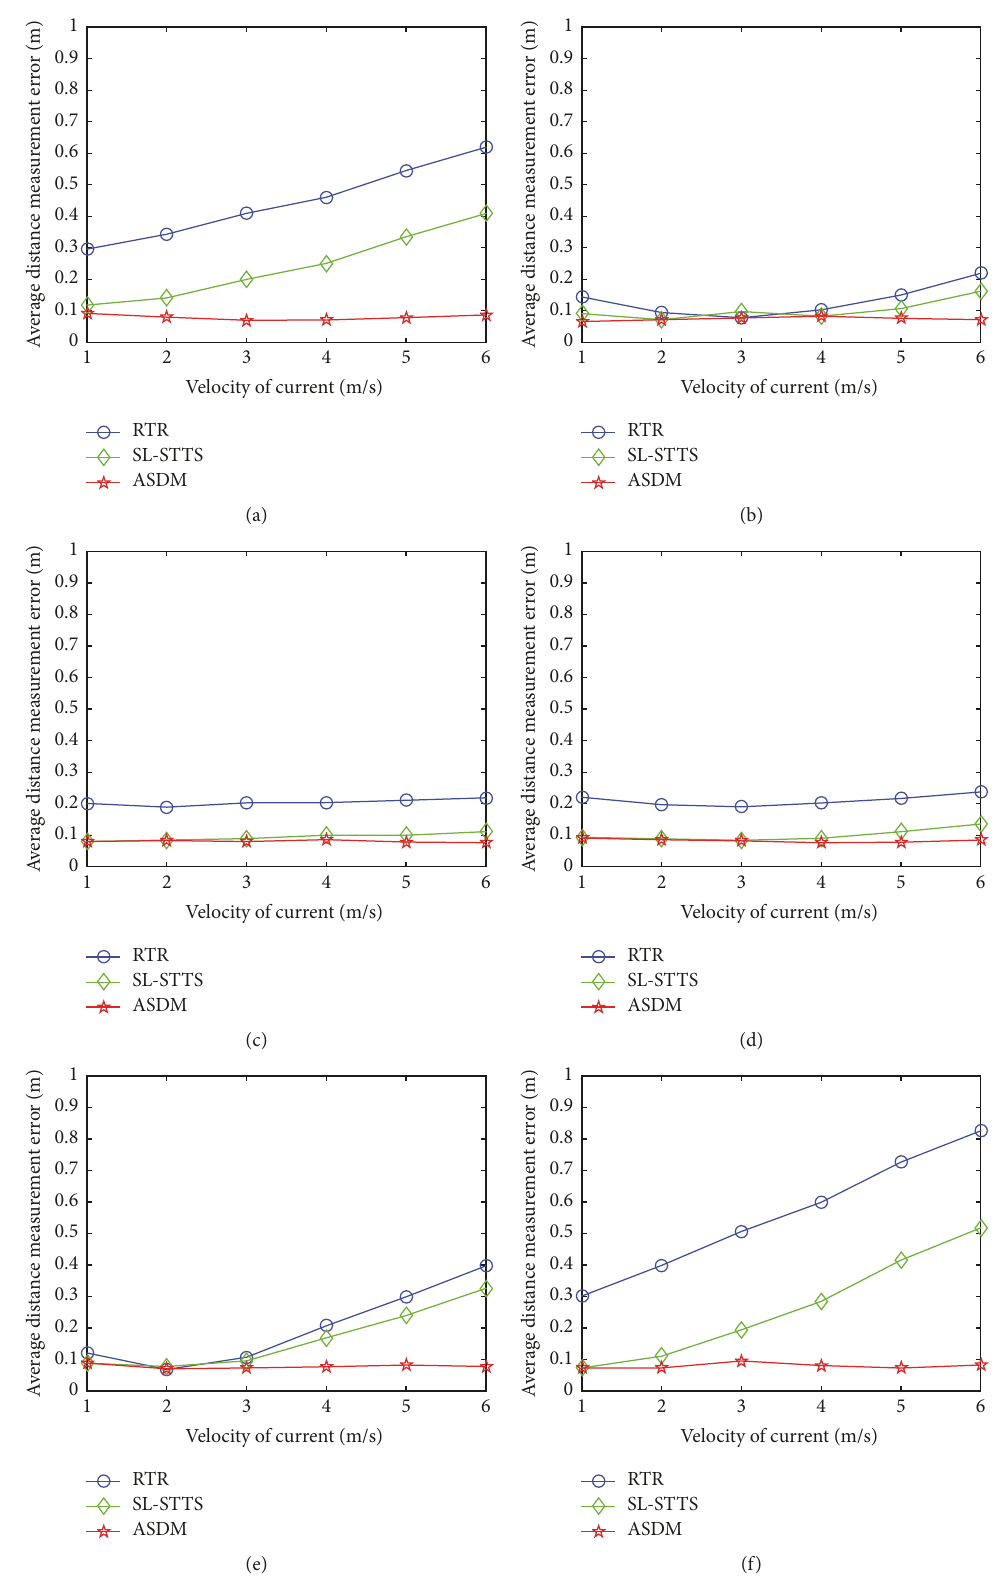
Figure 5: Average distance measurement error versus velocity of current: (a) the angle between 𝑒 𝑟 and 𝑒 𝑎 𝑓 is 0; (b) the angle between 𝑒 𝑟 and 𝜋 ; and ((c), (d), (e), (f)) the angle between 𝑒 𝑒 𝑏 𝑓 is